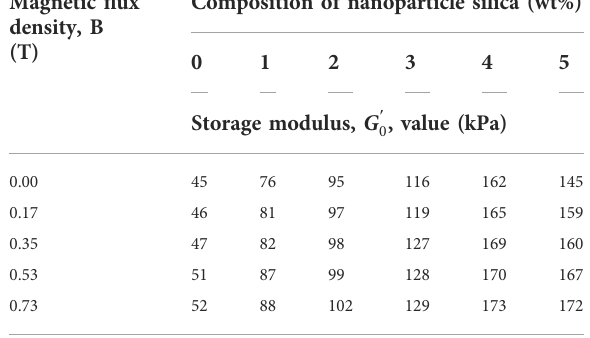
TABLE 2 | Initial storage modulus, G 9 0 , value of MR foam with different composition of silica nanoparticle at the off-state and on-state